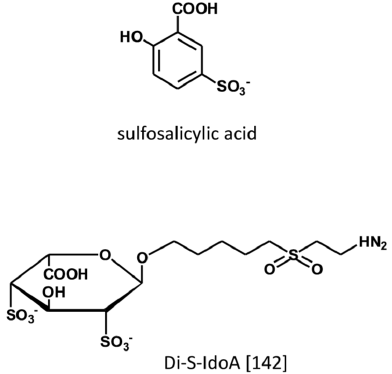
Figure 9. Small molecule interacting with the heparin-binding site of chemokines. Structure redrawn from ref [142].